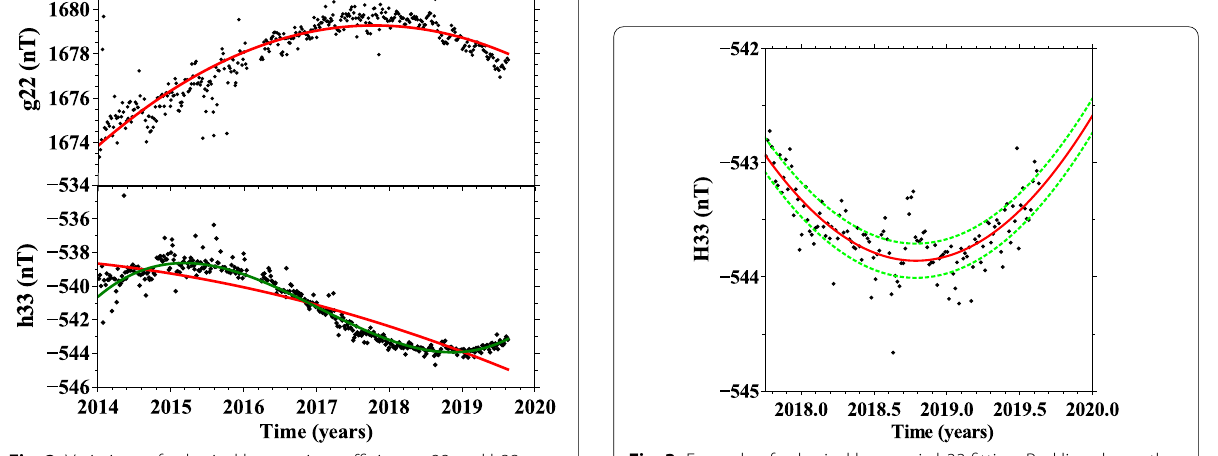
Fig. 2 Variations of spherical harmonic coefficients g22 and h33 over the period 2014–2020. Red lines show parabolic fit to data, green— cubic fit